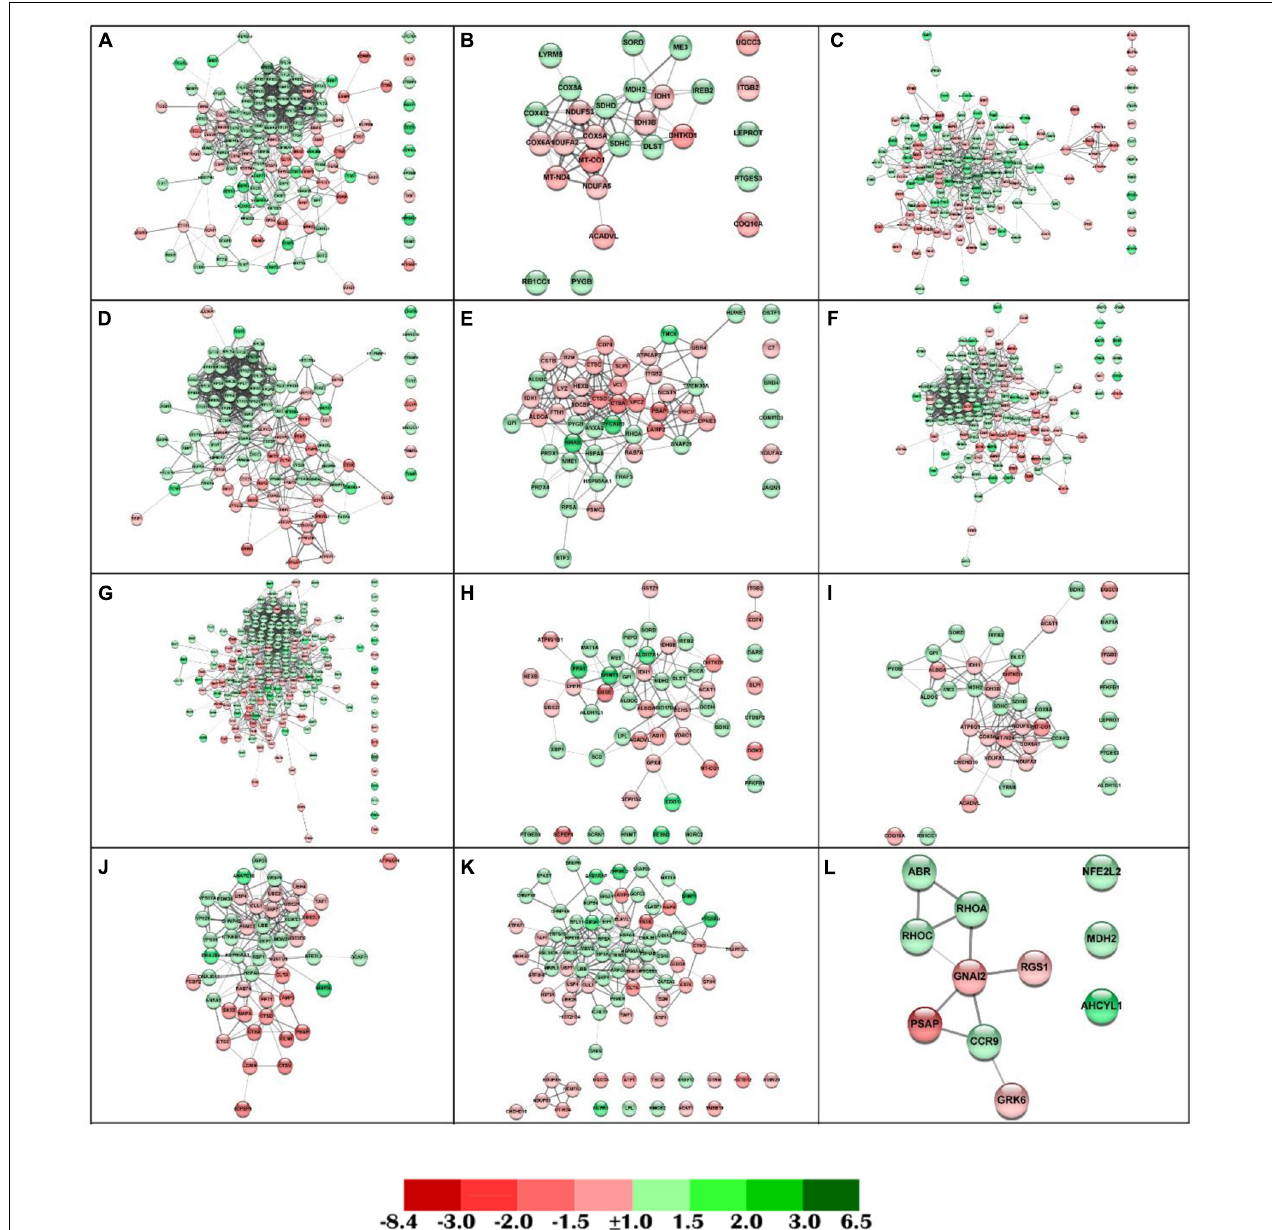
FIGURE 5 | Detailed functional networks for those DEGs belonging to the most representative GO terms for each enrichment cluster for biological functions. Each node represents one differential expressed gene (DEG) obtained from the anterior intestine transcriptomic analysis. (A) Cellular catabolic process. (B) Energy derivation by oxidation of organic compounds. (C) Response to organic substance. (D) Protein transport. (E) Leukocyte mediated immunity. (F) Organic substance catabolic process. (G) Protein metabolic process. (H) Carboxylic acid metabolic process. (I) Generation of precursor metabolites and energy. (J) Protein catabolic process. (K) Protein containing complex subunit organization. (L) G protein-coupled receptor signaling pathway. The DEG modulatory profile is represented with green (up-regulated) and red (down-regulated) into each node according to its fold-change magnitude interval scheme (detailed at the bottom of the